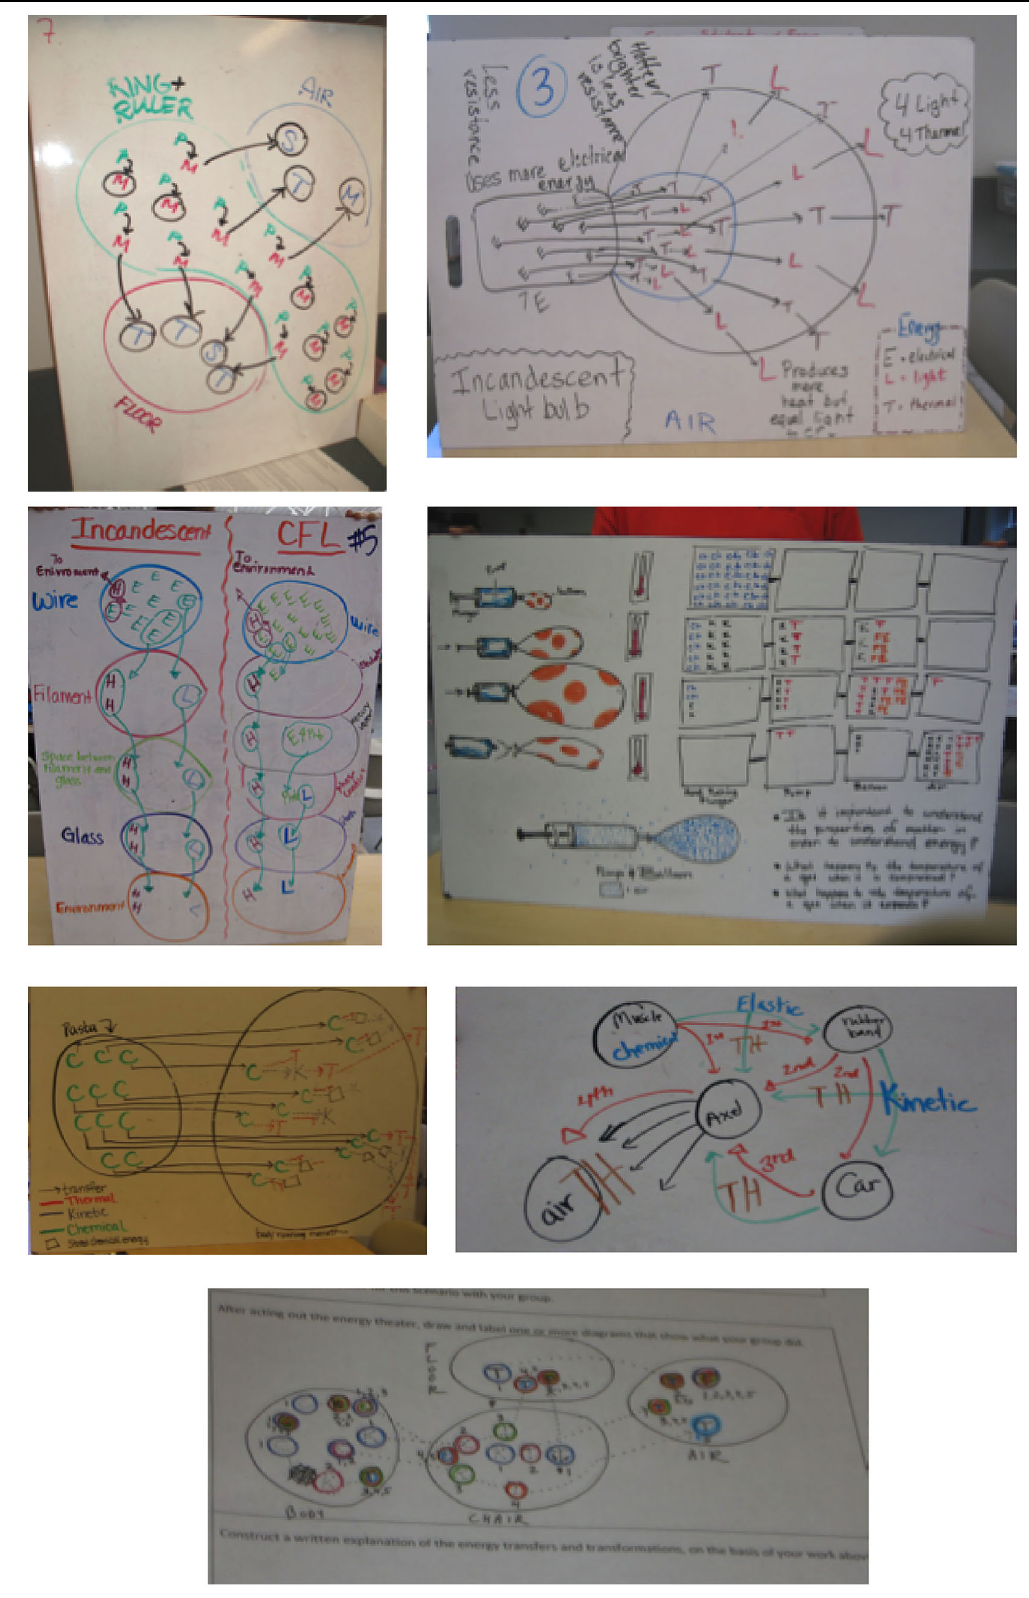
FIG. 3 (color online). Learner-invented representations that track energy transfers and transformations in (a) a ring smacked across the floor by a bent-back meterstick, (b) an incandescent light bulb burning steadily, (c) incandescent and compact fluorescent light bulbs, (d) a pumped balloon, (e) a runner eating pasta, (f) a pullback car, (g) a person pushing a